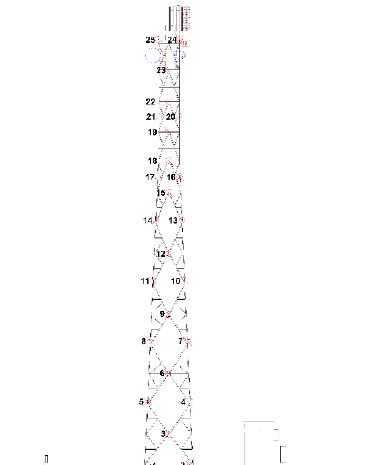
Figure 5. Topographic survey scheme – position of the points